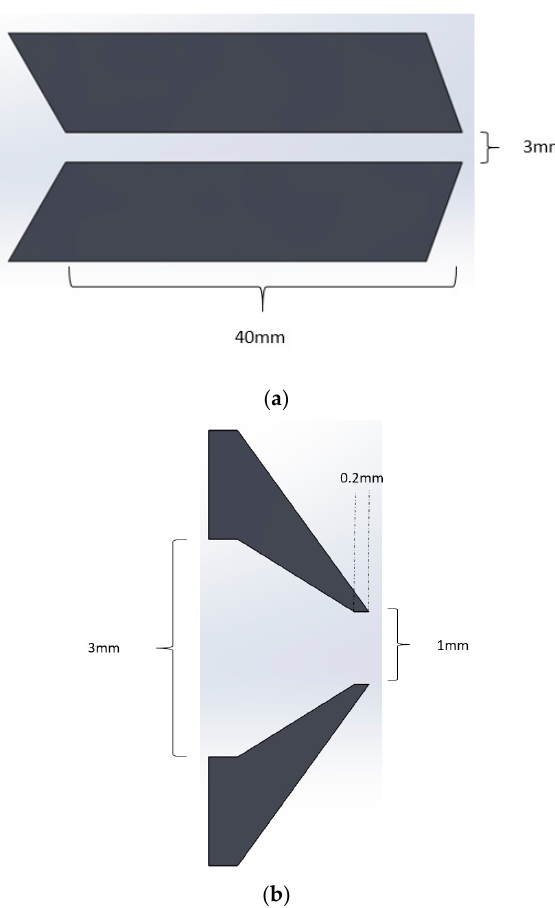
Figure 13. Comparison of capillary geometries for ( a ) filament extrusion and ( b ) 3D printing. Table 2. Comparison of specific strength values for 3 mm printing and 1 mm printed filament.